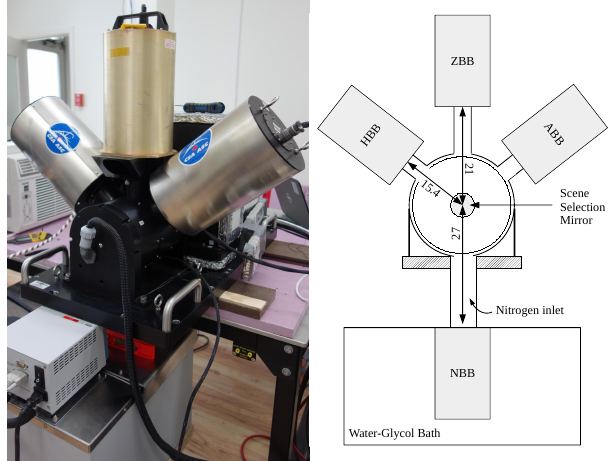
Figure 4. Left: laboratory experimental setup for instrument charac- terization. The lateral blackbodies are those of the FIRR while that in zenith position was temporarily mounted. The white container at the bottom holds another blackbody immersed in a water-glycol bath regulated by a cryogenic system. Right: schematic front view of the setup. The circle in the middle represents the scene selection mirror. Distances are in centimeters. Figure 5. (a) Standard deviation of measurements performed on the ABB for different illuminated areas. The area is defined as disks around the central pixel. The average over 10 consecutive sequences is shown. (b) Average gain over the same 10 sequences for all bands. Horizontal bars highlight the spectral extent of the